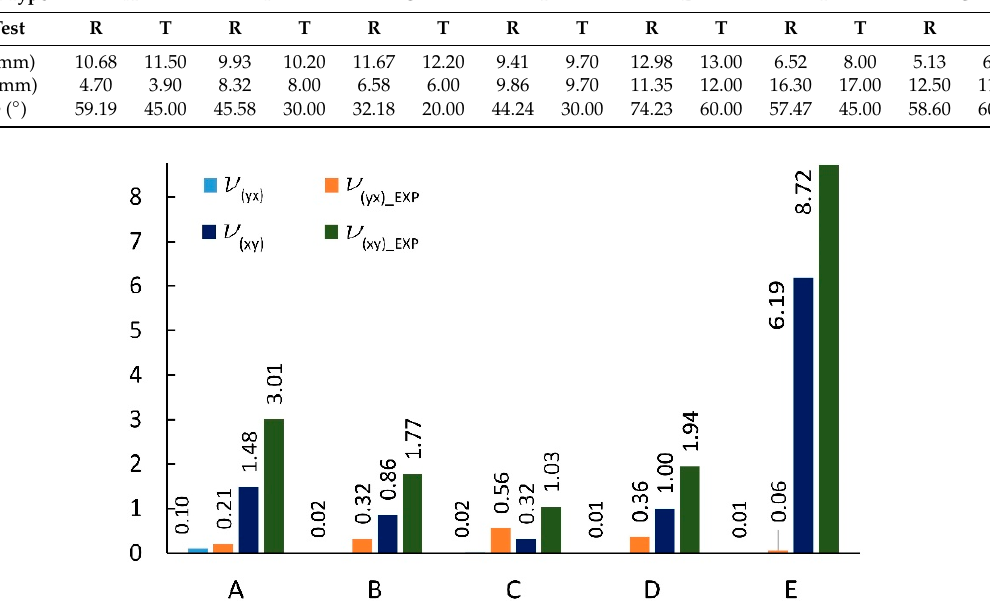
Materials 2020 , 13 , x FOR PEER REVIEW Figure 8. Poisson’s ratio for cells of the type: A, B, C, D, E (EXP-experimental research).